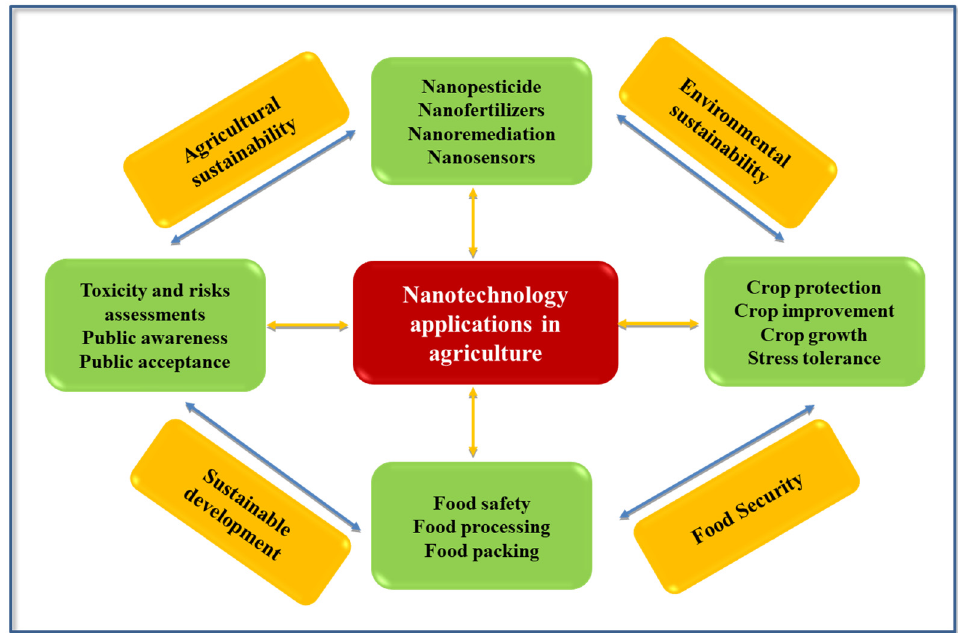
Figure 1. Nanotechnology applications in agriculture. Nanopesticides and nanofertilizers provide targeted and controlled release of active ingredients (AI), reducing environmental impact while sustaining plant protection from disease and crop yield, respectively; ENMs for soil remediation are regarded as more efficient tools for polluted soils clean-up; nanosensor devices are suitable for monitoring either plant stress or food quality and safety. Similarly, they play a role in food processing and packaging.